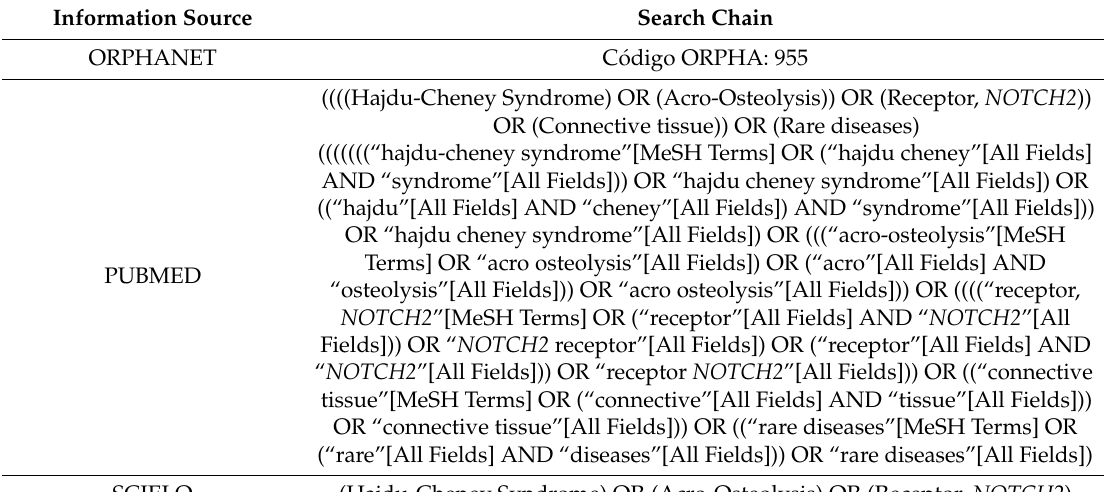
Table 1. Search chains